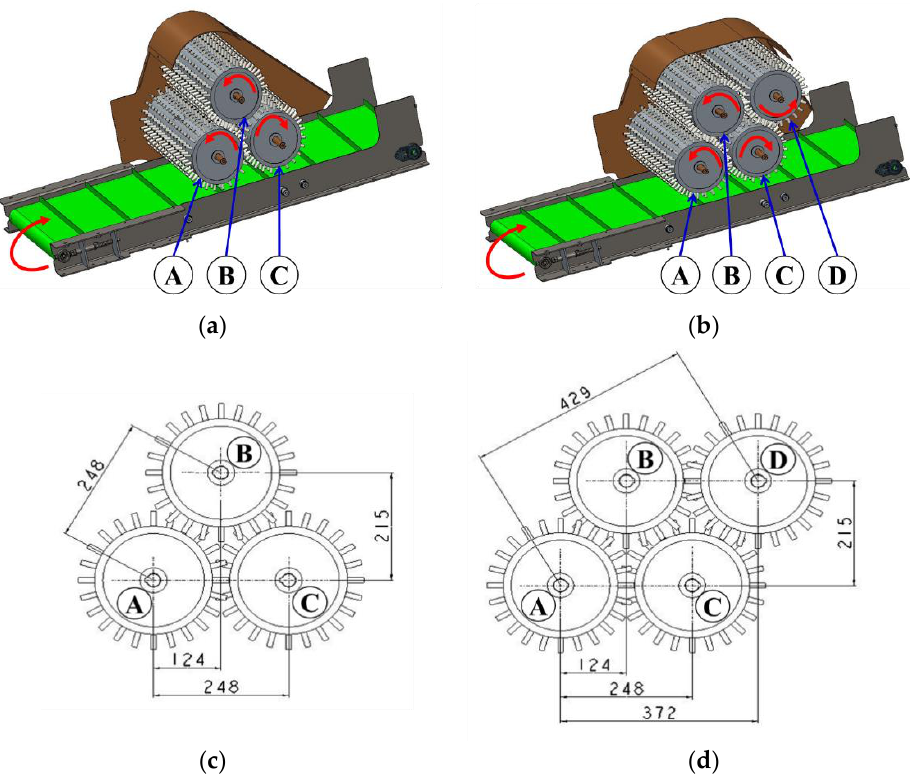
Figure 2. 3D design of three-shaft drum ( a ) and four-shaft drum ( b ) of the drum-type stem-separating part. ( c ) Side view of the three-shaft drum type and ( d ) four-shaft drum type.